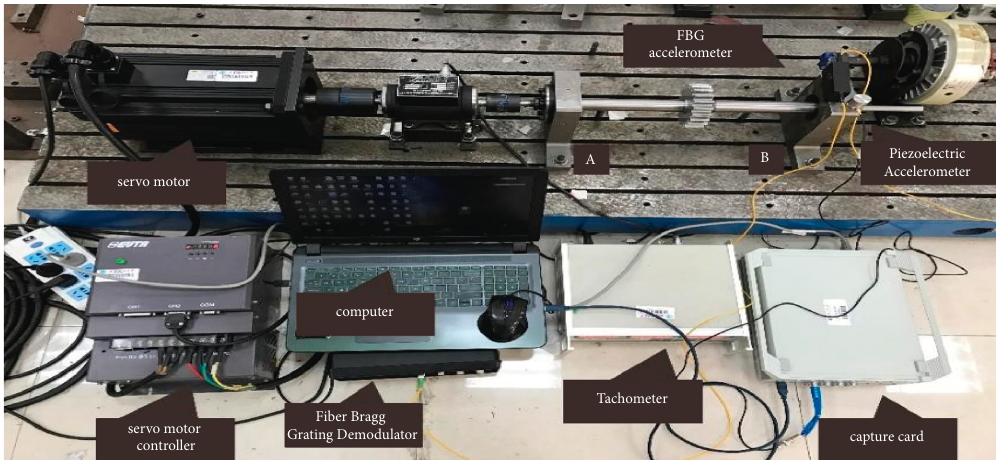
Figure 3: Rolling bearing experimental platform.